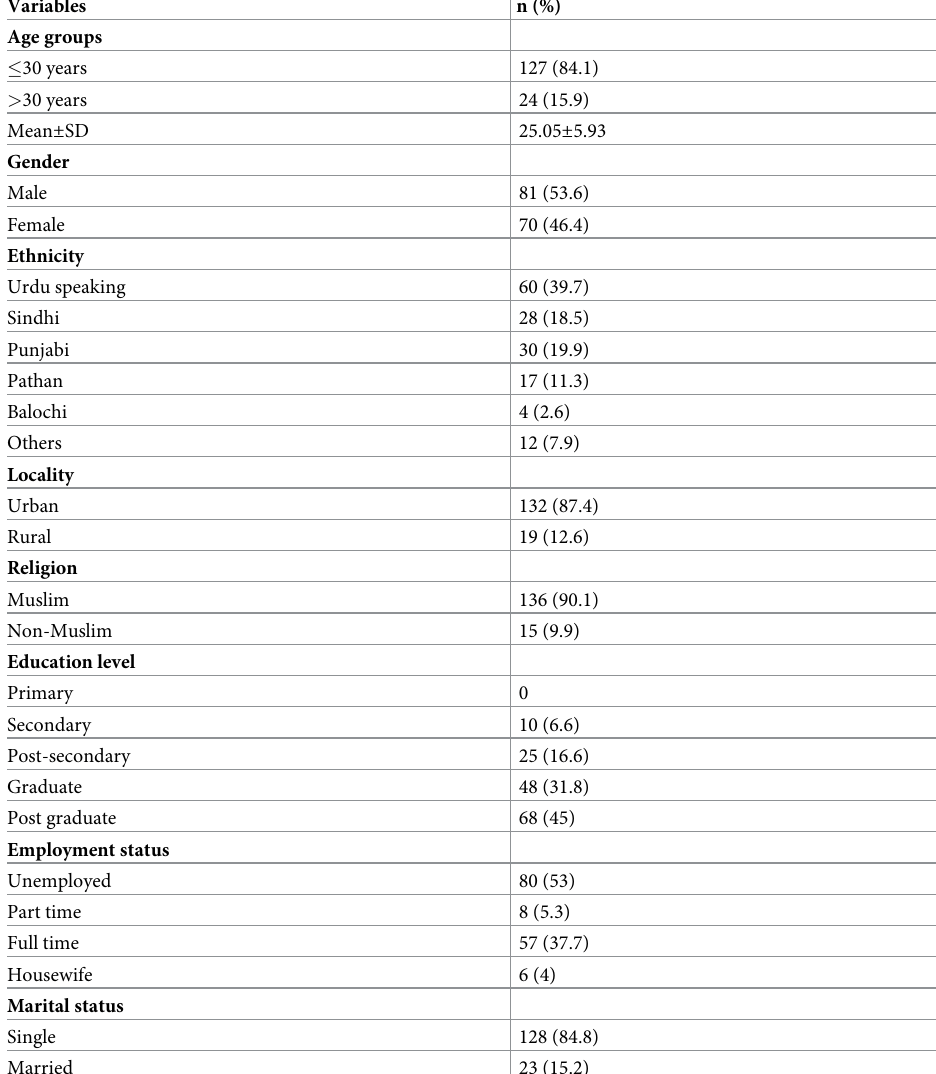
Table 1. Demographic information of study participants with face mask adherence (n =